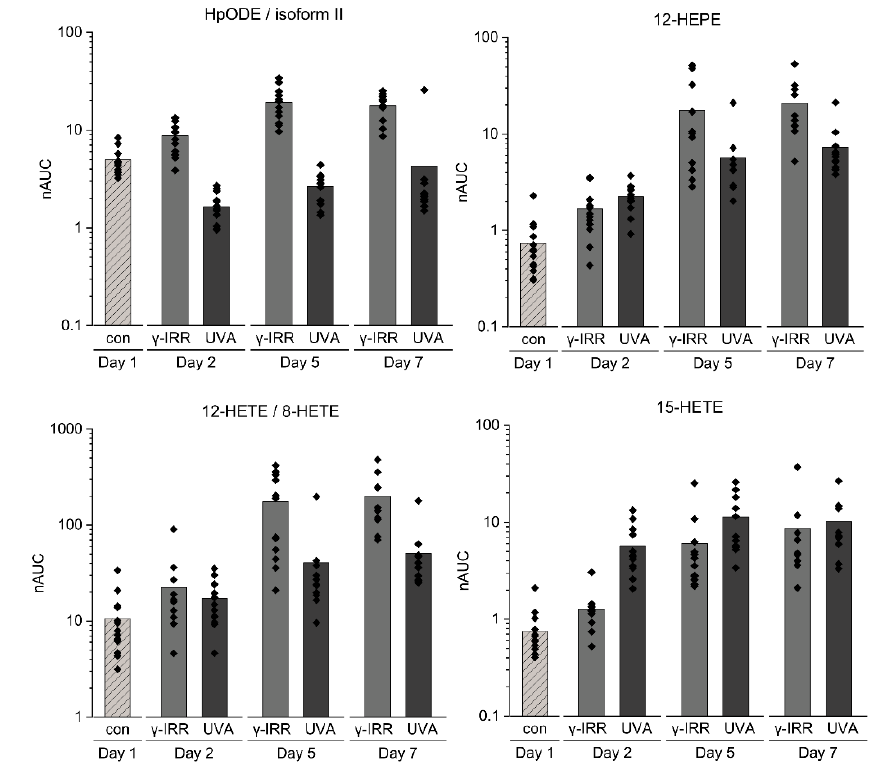
Figure 4. ( A ) Volcano plot of the comparison of γ -IRR and INTERCEPT-treated platelet concentrates on day 7. While the immediate effects observed on day 2 were still detectable, an additional down- regulation of 12-LOX products 12-HETE and 12-HEPE was observed. Significant regulations with p -value < 0.05 and log2 fold change (Log2FC) > |1| (red), p -value < 0.05 (blue), Log2FC > |1| (green) and nonsignificant results (grey). ( B ) Time course analyses of the selected molecules as described in the